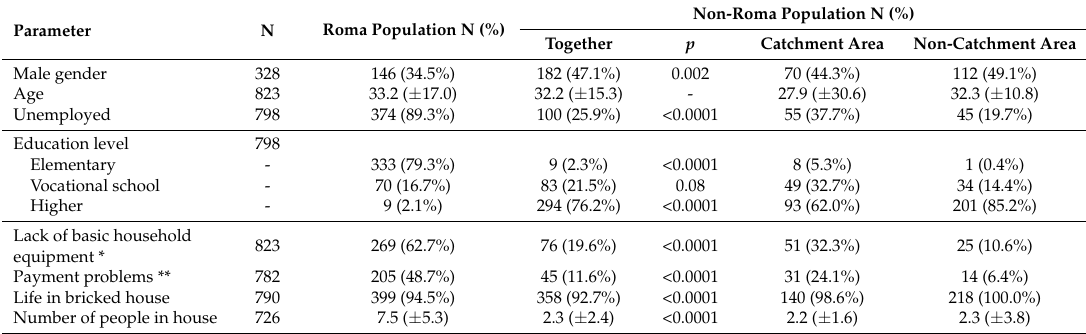
Table 1. Baseline parameters of the study.